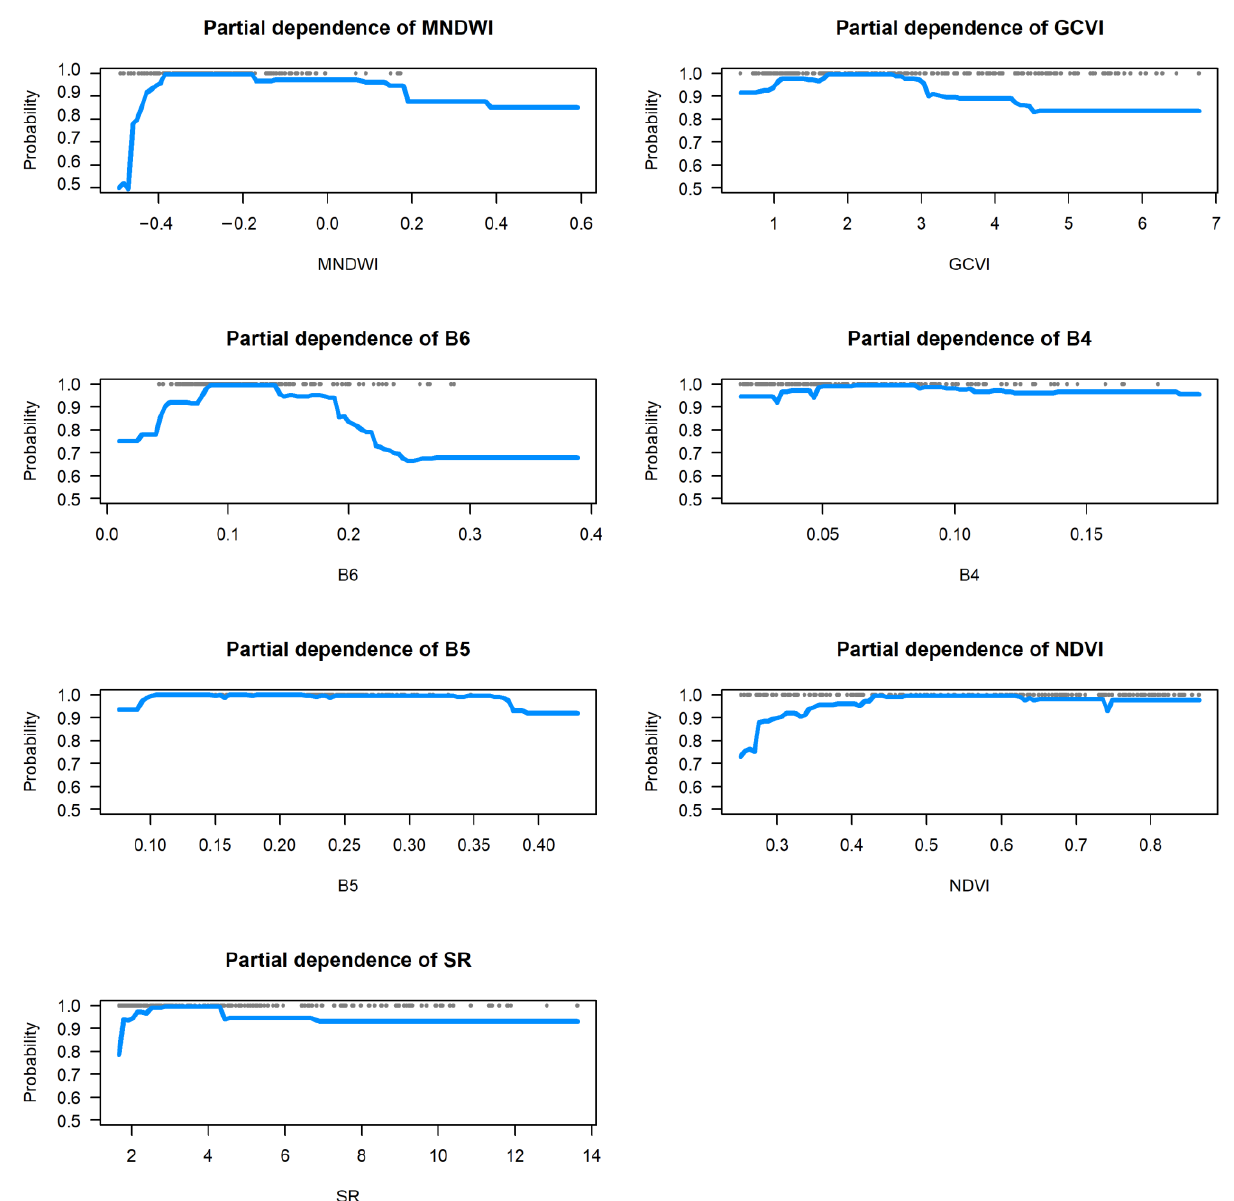
Figure 3. Partial dependence plots for randomForest showing the influence, in order of importance (see Table 1) of remote sensing bands Landsat 8 remote sensing bands 4, 5 and 6 and band composites GCVI, NDVI, MNDWI and SR from a 4-year optimal median composite on the prediction of mangrove versus non-mangrove habitat. It is apparent that mangrove detectability increases when water indices (MNDWI) reduce and indices associated with vegetation (chlorophyll) increase (e.g., GCVI, NDVI) (see Figure SI4).